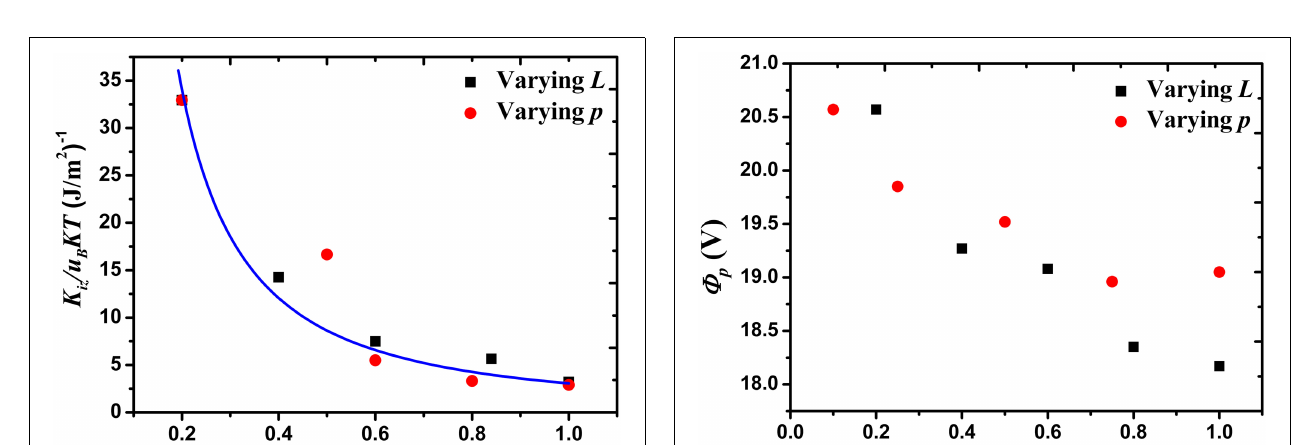
FIGURE 8 | Comparison of the simulated results with the particle balance model with varying (A) length and (B) pressure.